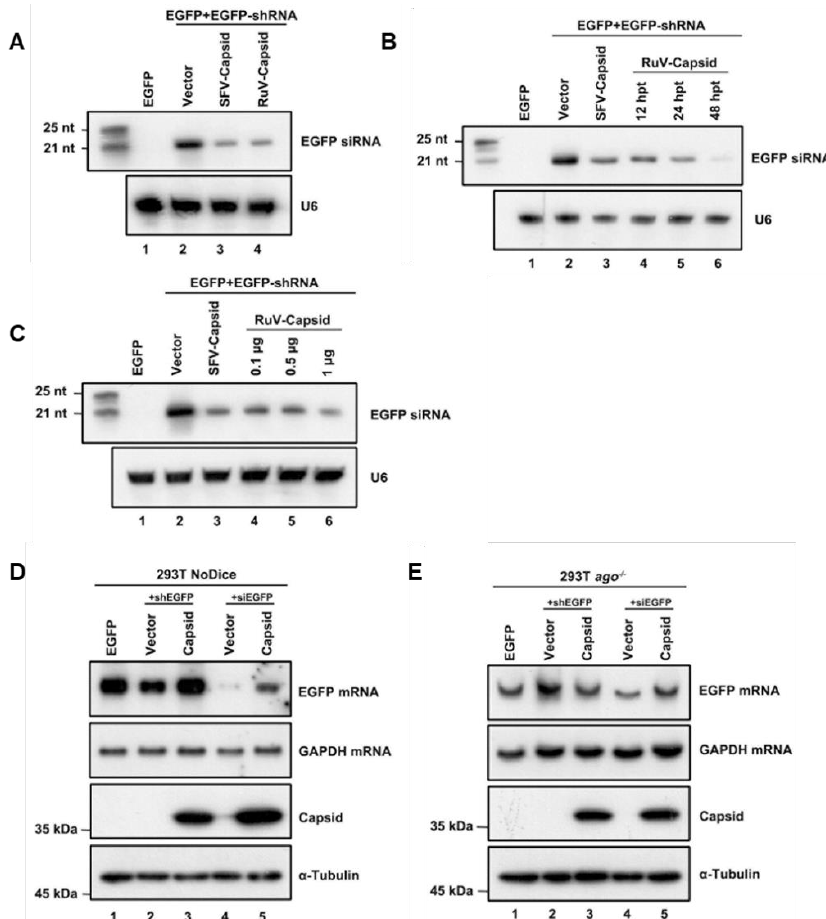
Figure 2. RuV capsid inhibits Dicer-mediated siRNA generation and siRNA-induced RNAi. ( A ) HEK293T cells were co-transfected with plasmids encoding EGFP (100 ng), EGFP-specific shRNA (shEGFP) (300 ng), and RuV capsid (1 µ g), respectively. Small RNA Northern blotting was performed to examine the levels of EGFP-specific siRNA. U6 was used as a loading control. Empty vector (Vec) and SFV capsid protein were used as a mock control and a positive control, respectively. The synthetic 21- and 25-nt RNAs were used as size markers. ( B ) Increasing amounts of capsid-encoding plasmid were transfected into HEK293T cells in the reversal-of-silencing assay. At 48 hpt, small RNA Northern blotting was performed to examine the levels of EGFP-specific siRNA. ( C ) Northern blotting was performed 12, 24, and 48 hpt. ( D , E ) HEK293T NoDice ( D ) or co-transfected plasmids encoding EGFP (100 ng), shEGFP (300 ng), or siEGFP (300 ng),